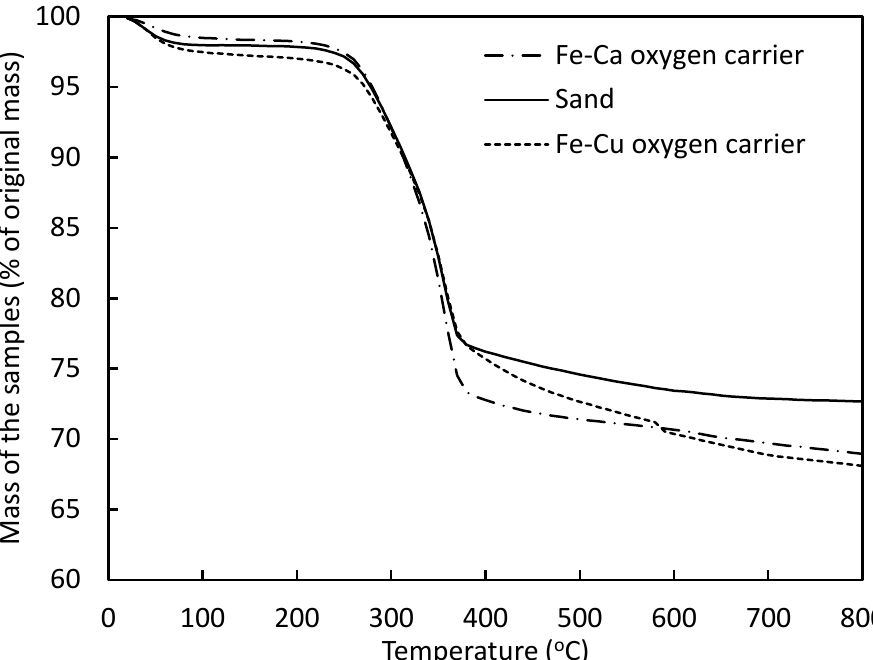
Figure 6. TGA profiles for the oxidation of biomass using Fe-Cu and Fe-Ca oxides at a 0.4:1 mass ratio of biomass to oxide.